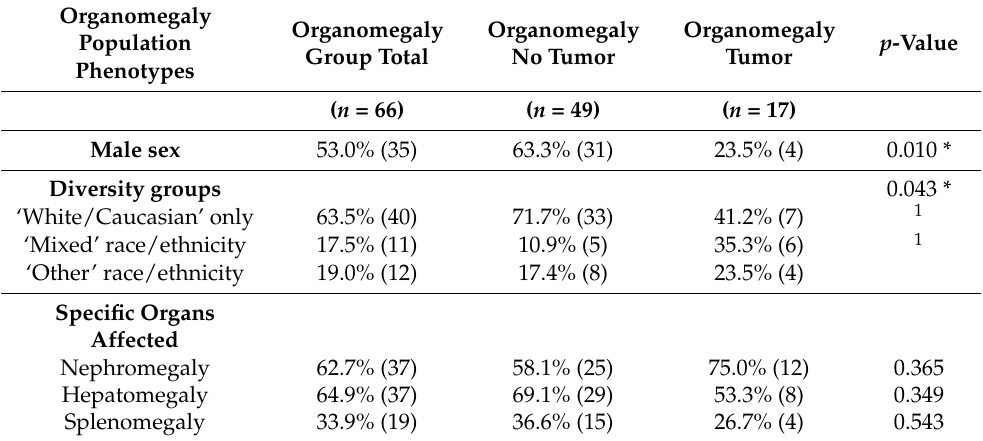
Table 7. Significant tumor phenotype associations within BWSp—Organomegaly